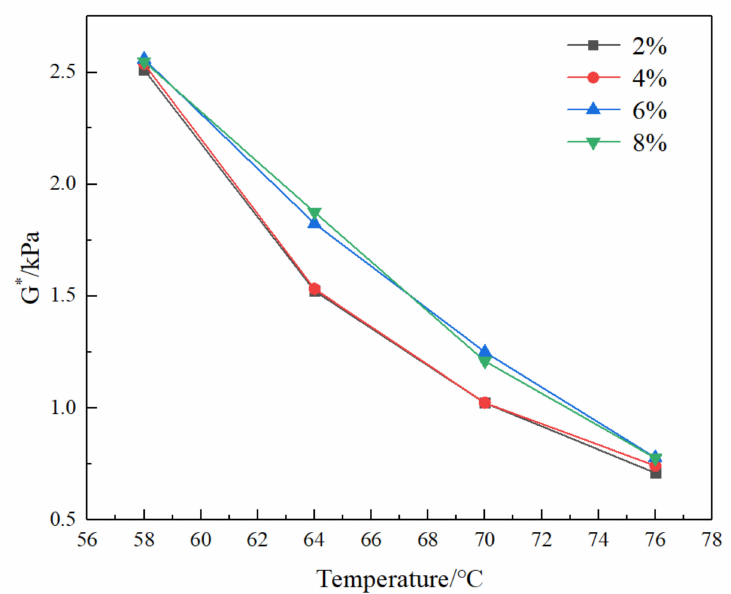
Figure 1. Curves of complex shear modulus G * of bitumen with di ff erent SF (silica fume) content with temperature.